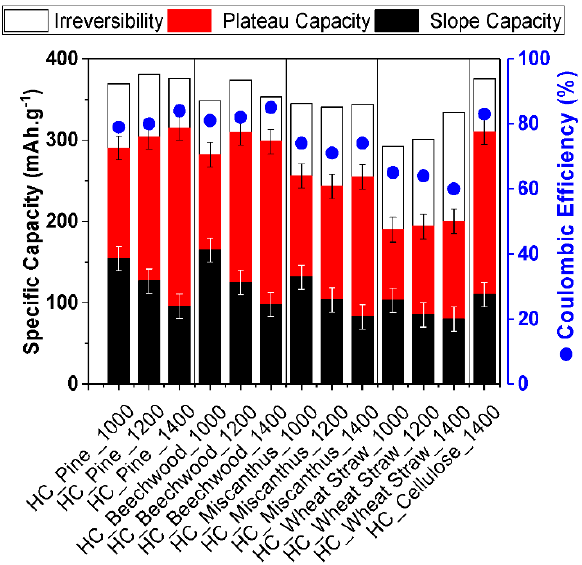
Figure 9. Analysis of the first cycle slope, plateau and irreversible capacities for all the series of hard carbons.